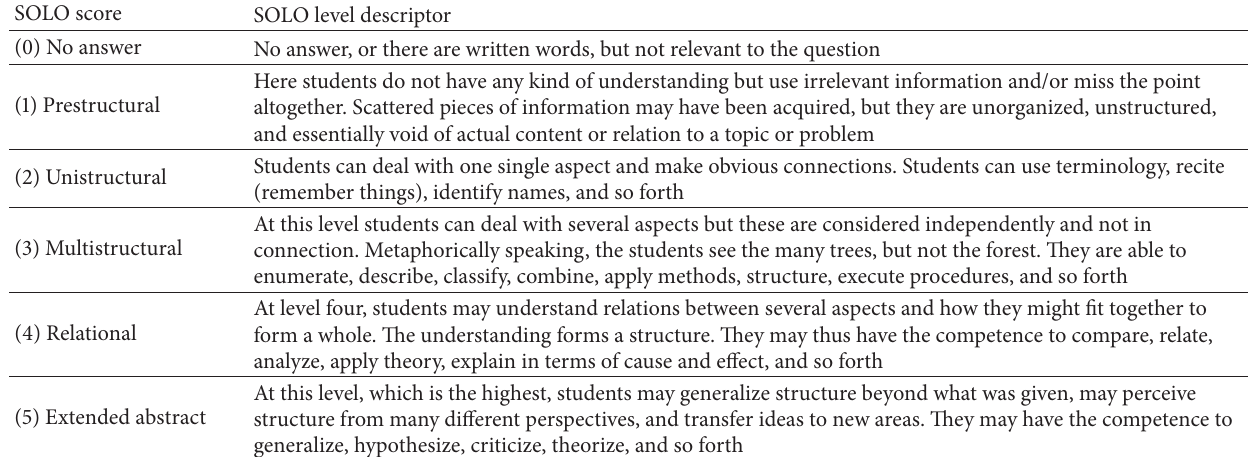
Table 1: SOLO scoring